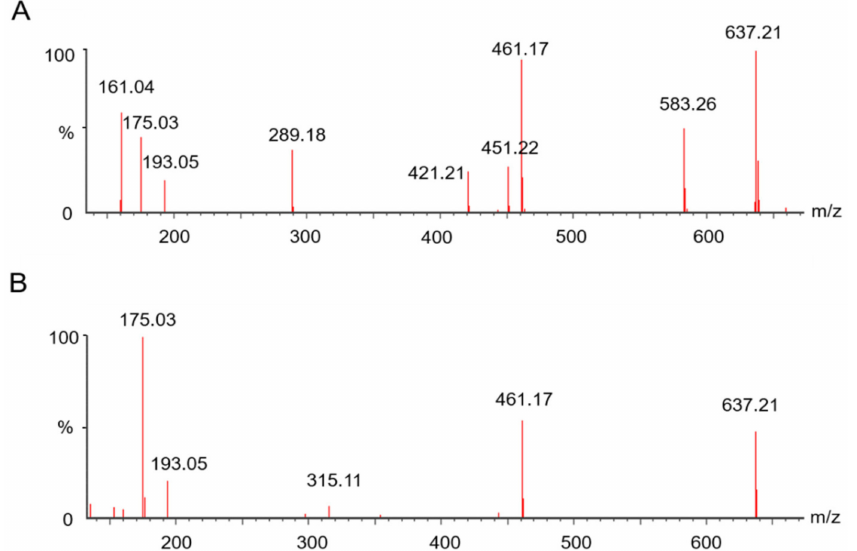
Figure 6. Mass spectrum corresponding to LC peak at 9.16 min: ( A ) the fragment ions were detected by UHPLC-Q-TOF-MS; ( B ) the fragments were detected by